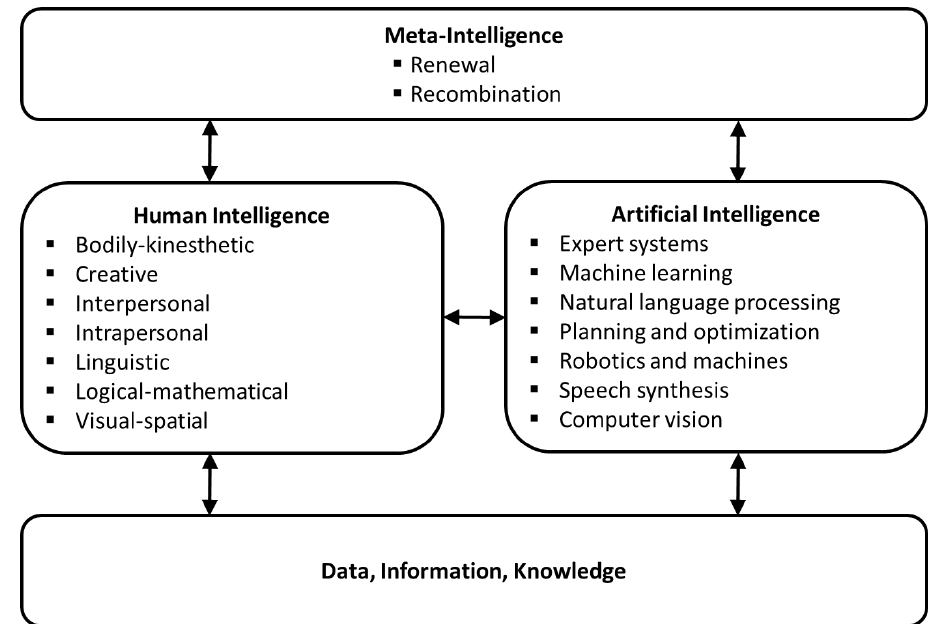
Fig. 1. Framework for an intelligence-based